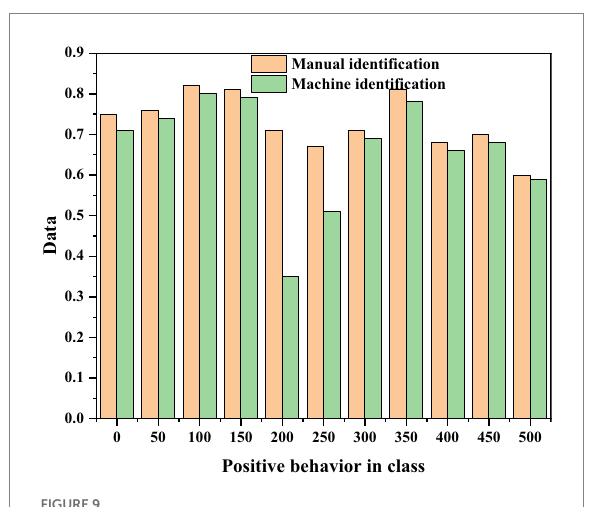
FIGURE 9 The trend chart of positive behavior ratio change in